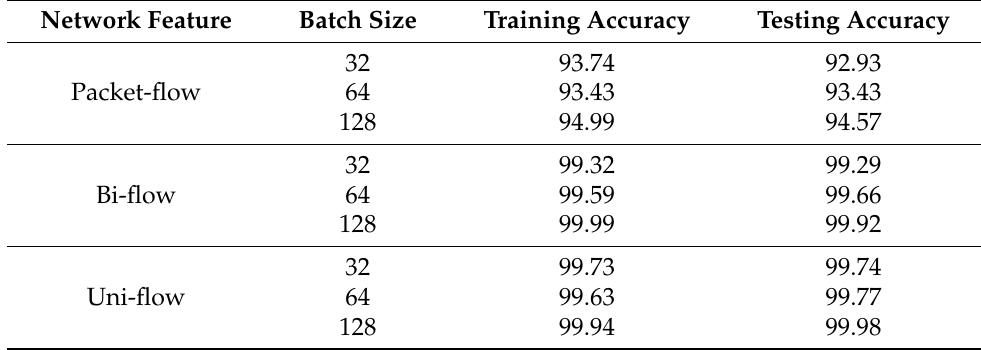
Table 6. Binary-class attack classification with the sigmoid activation function in the output layer.